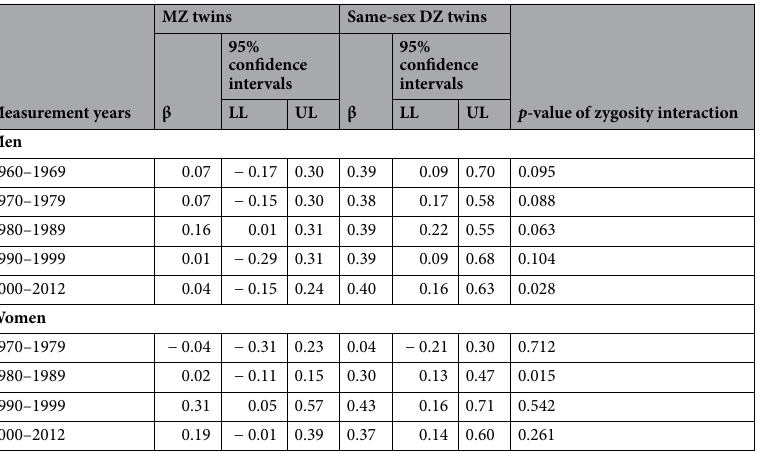
Table 5. Educational years in former smokers as compared to current smokers within discordant twin pairs by measurement year, zygosity and